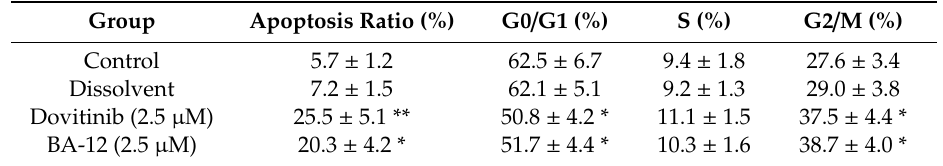
Table 1. E ff ects of a ligustrazine–betulinic acid derivative (BA-12) on apoptosis and cell cycle of human